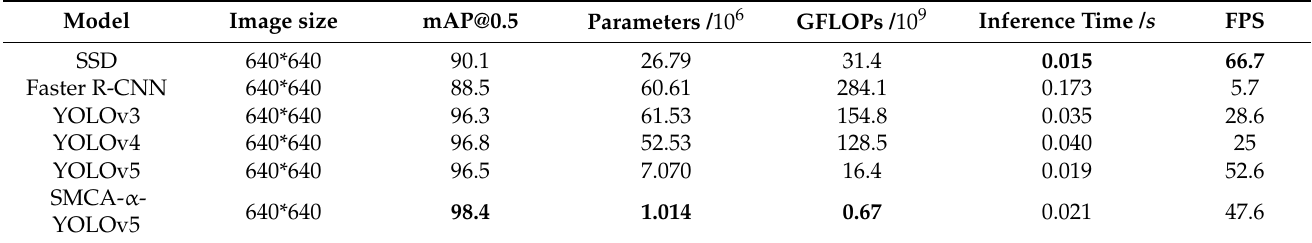
Table 6. Performance comparison results of different algorithms.